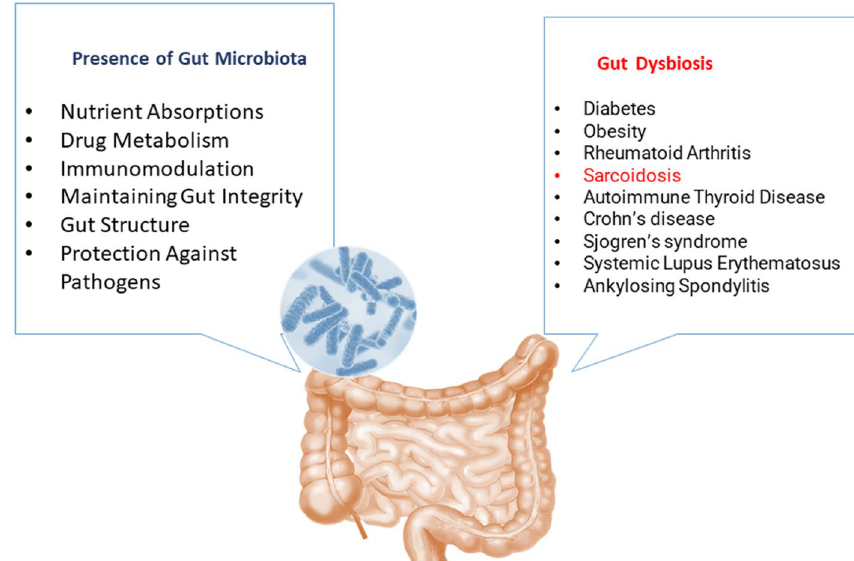
Fig. 1 The relation between the presence or absence of microbiota and gut